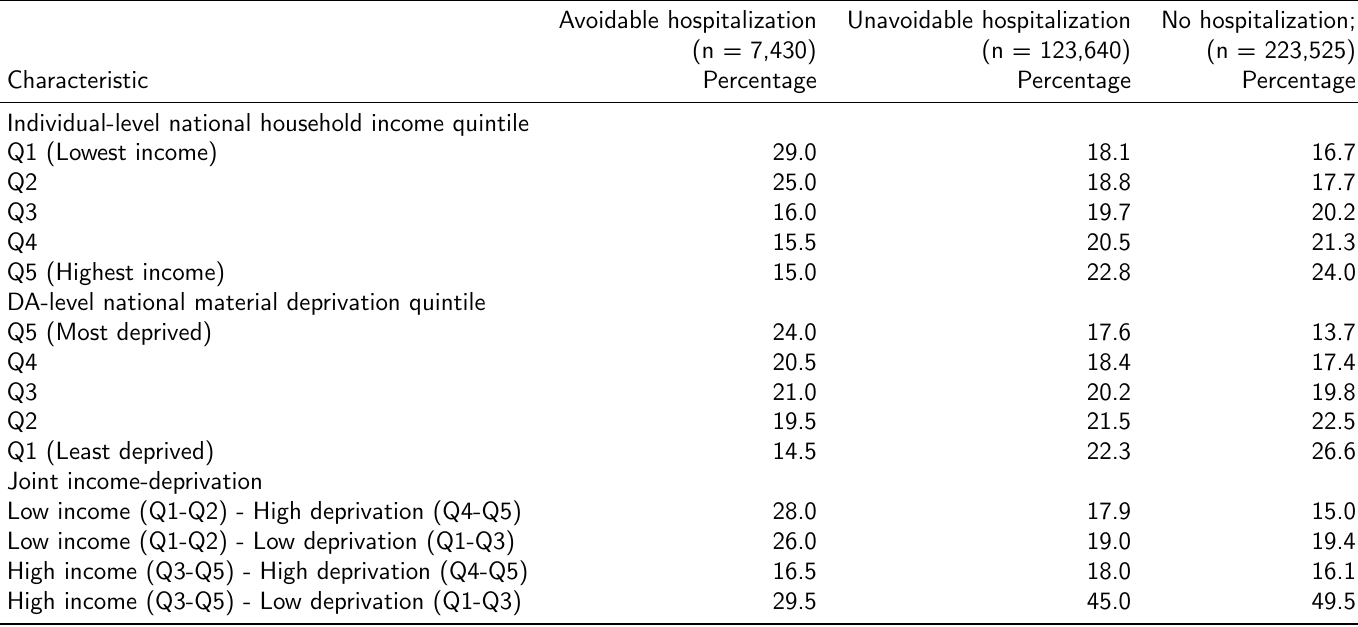
Table 1: Socioeconomic exposures of pooled CCHS respondents (cycles 2000/2001 - 2011) with complete exposure information stratified by type of prospective hospitalization (n =